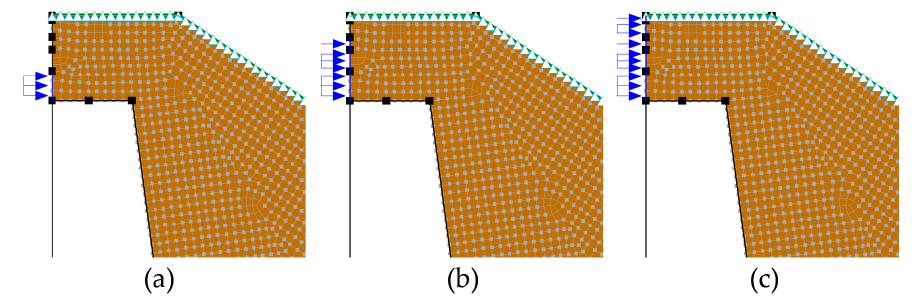
Figure 8. Input boundary flux shown for ( a ) q = 1 × 10 − 3 m 3 /s, ( b ) q = 2 × 10 − 3 m 3 /s and ( c ) q = 4 × 10 − 3 m 3